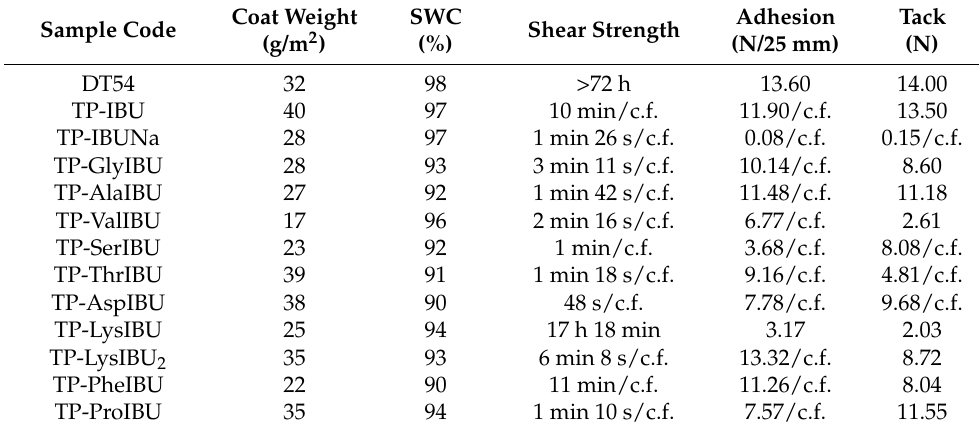
Table 1. Self-adhesive properties of the transdermal patch containing various active